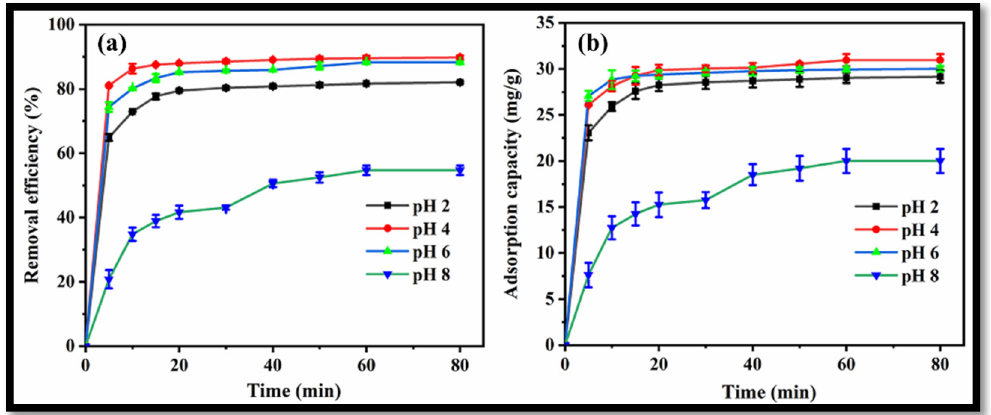
Figure 9. ( a ) Removal efficiency and ( b ) adsorption capacity of rGO-WO 3 heterostructure at varying pH values.